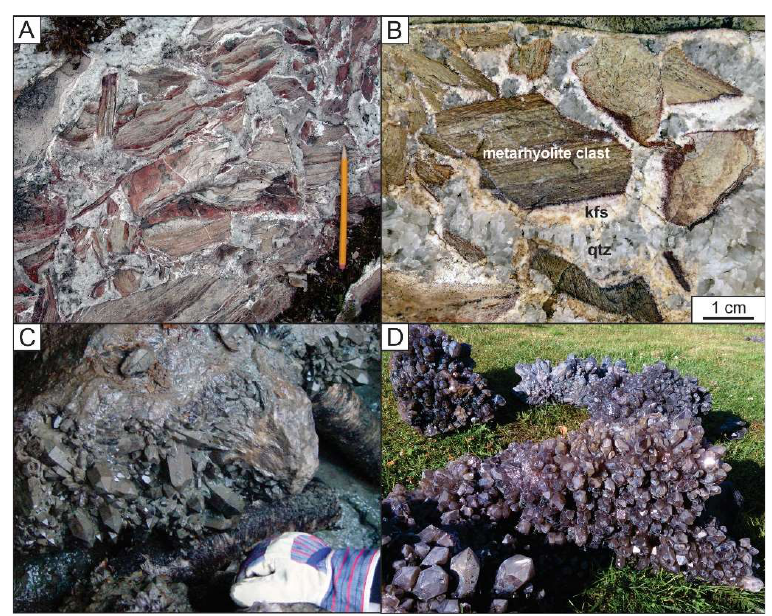
Figure 3. Photographs of the Berglia-Glassberget breccia. ( A ) Outcrop in the center of the Berglia-Glassberget breccia. ( B ) Hand specimen exhibiting typical texture of the Berglia-Glassberget breccia. The white mineral enveloping the metarhyolite clasts is K-feldspar (kfs), which crystallized prior to quartz (qtz). ( C ) Recovering of a large cluster of smoky quartz crystals from the 3 m × 3 m × 4 m cavity discovered in 2005. ( D ) Cleaned crystal clusters from the cavity shown in ( C ). Photograph by Arne Jostein Devik.